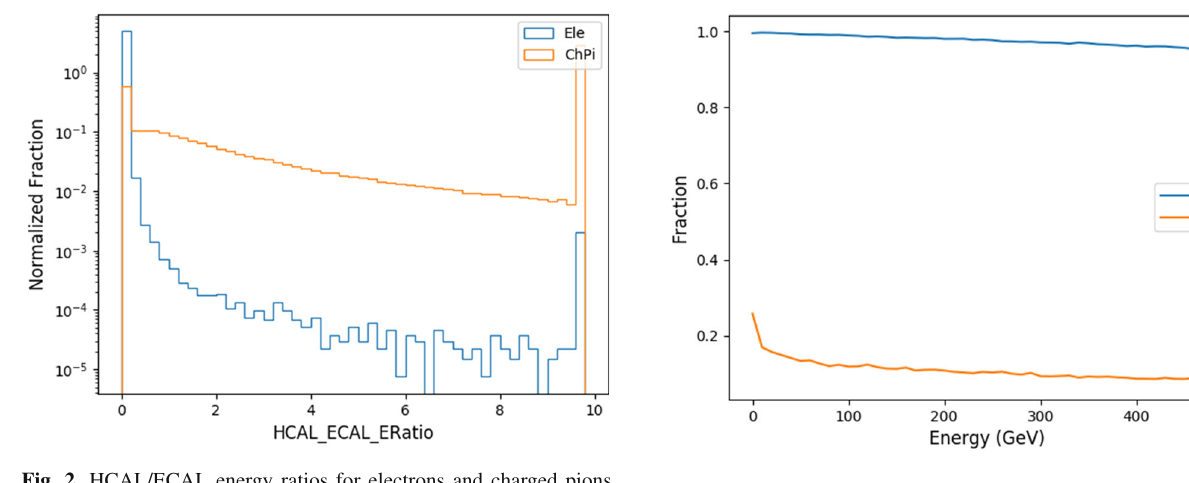
Fig. 2 HCAL/ECAL energy ratios for electrons and charged pions, plotted on a log scale. The last bin is an overflow bin